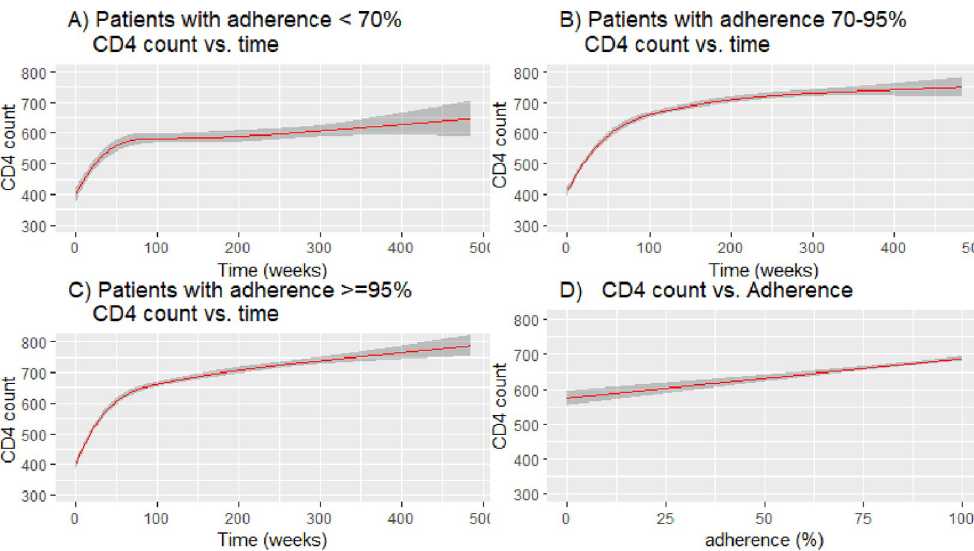
Fig 2. (A) Fitted model for CD4 count vs. time in weeks among patients with adherence < 70% throughout the study; (B) Fitted model for CD4 count vs. time in weeks among patients with adherence between 70% & 95% throughout the study; (C) Fitted model for CD4 count vs. time in weeks among patients with adherence > = 95% throughout the study; (D) Fitted model for CD4 count vs. adherence